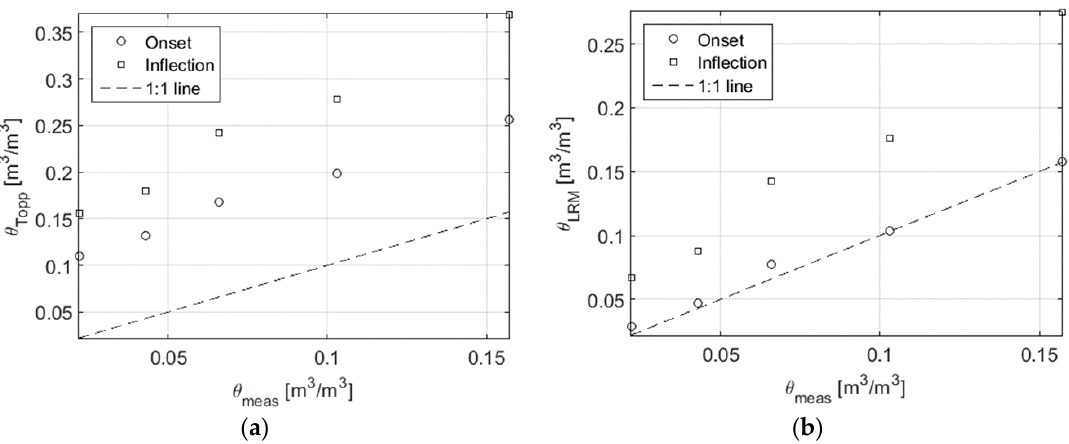
Figure 11. Estimated water content with Topp equation ( a ) and LRM ( b ) computed with apparent permittivity obtained by onset and inflection method for the rods in contact.